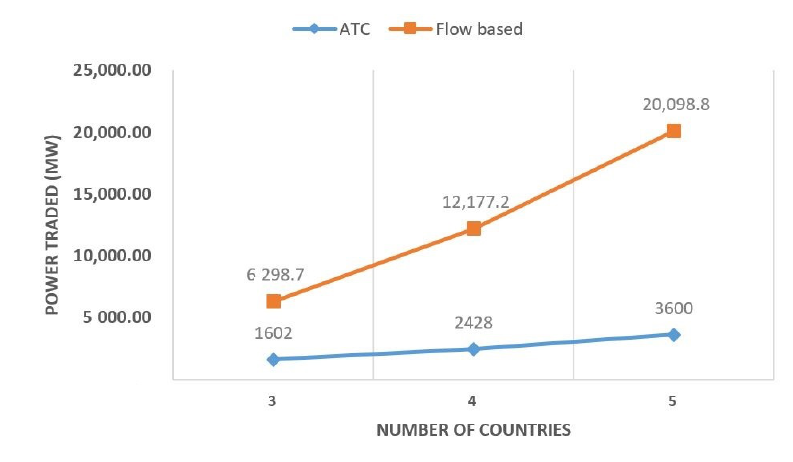
Figure 5. Volume of power traded for different number of countries.